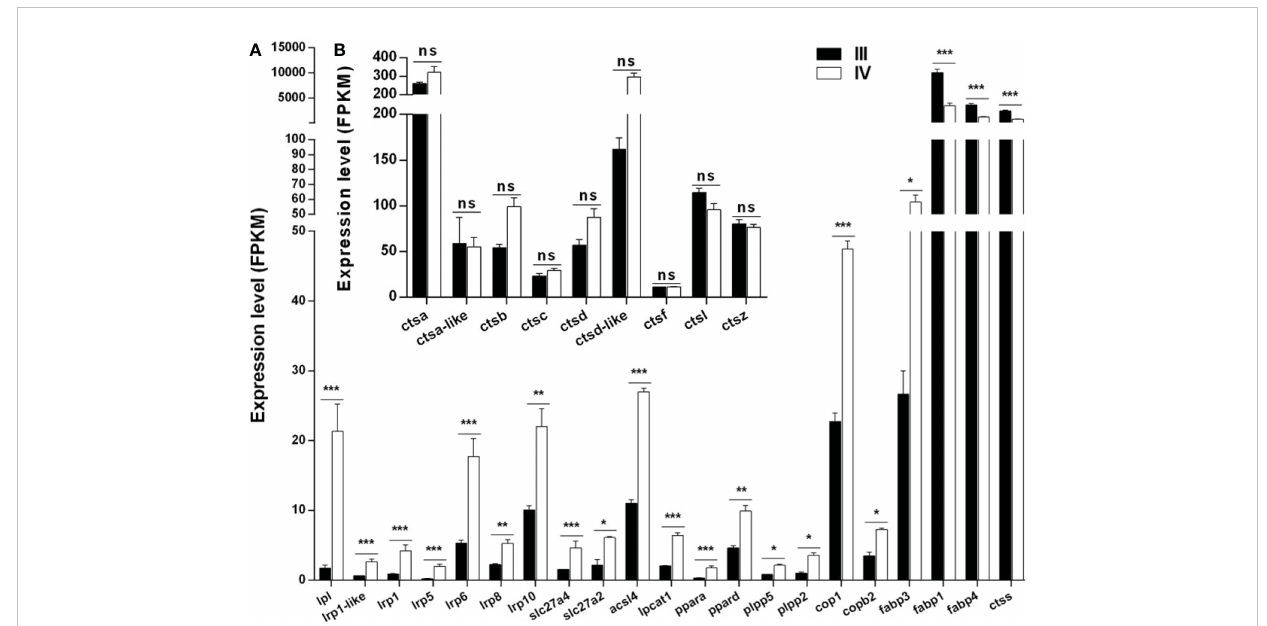
FIGURE 7 Histogram showing the expression of genes associated with lipid droplet and yolk production. (A) Expression of DEGs (log2 (FC) >1 and FDR <0.05) involved in lipid droplet and yolk production in stage III and IV ovary of S. argus . (B) Expression of genes (log2 (FC) ≤ 1 or FDR > 0.05) involved in vitellogenin catalysis. The data is based on the FPKM values obtained from the RNA-seq data. *, P<0.05; **, P<0.01; ***, P<0.001; ns, No signi fi cant